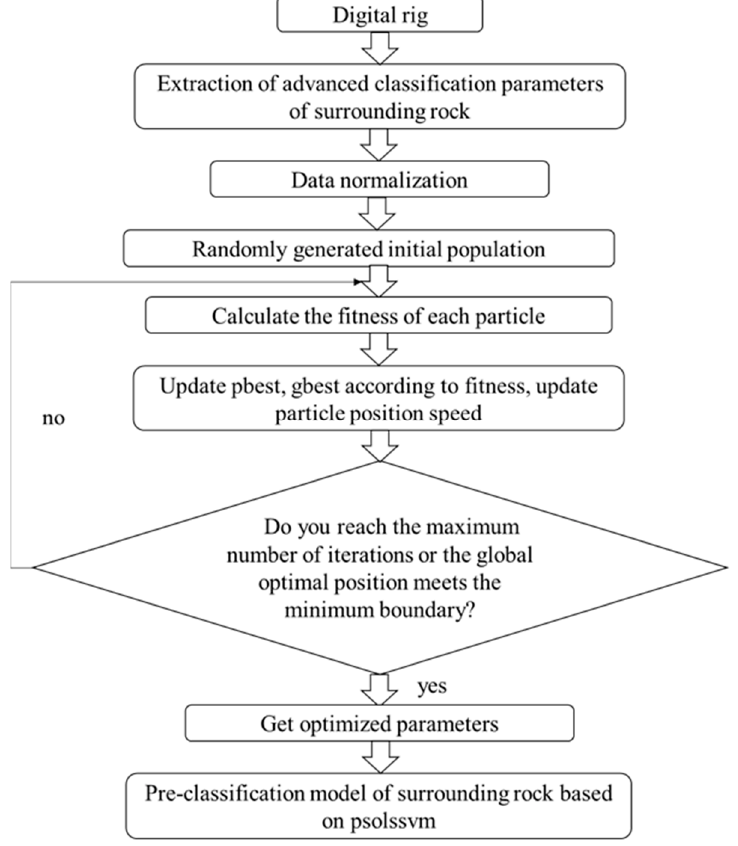
Figure 2. Flow chart of a calculation based on PSOLSSVM.